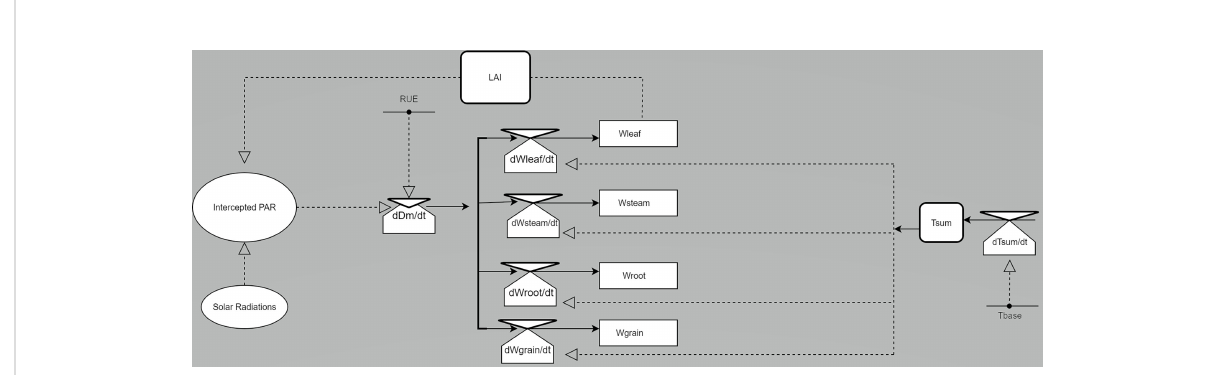
FIGURE 1 Relational diagram of LINTUL-1 to simulate the potential yield [modi fi ed from Nyombi (17)]. Wleaf, weight of leaves; Wstem, weight of stems; Wroot, weight of roots; Wgrain, weight of grain; Dm, dry matter. LAI, leaf area index; Tbase, the low lowest temperature for the crop to grow; PAR, photosynthetic active radiation; RUE, Radiation (light) use ef fi ciency; Tsum, accumulated temperature.